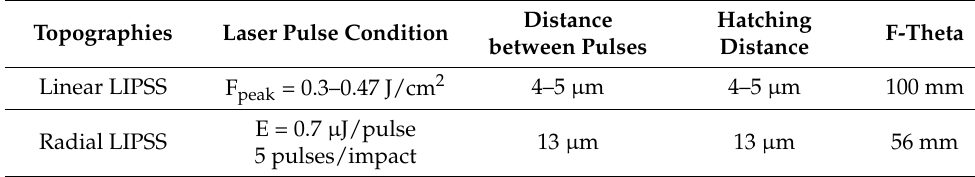
Table 1. Laser parameters used to create the different titanium alloy textured surfaces. Topographies Laser Pulse Condition